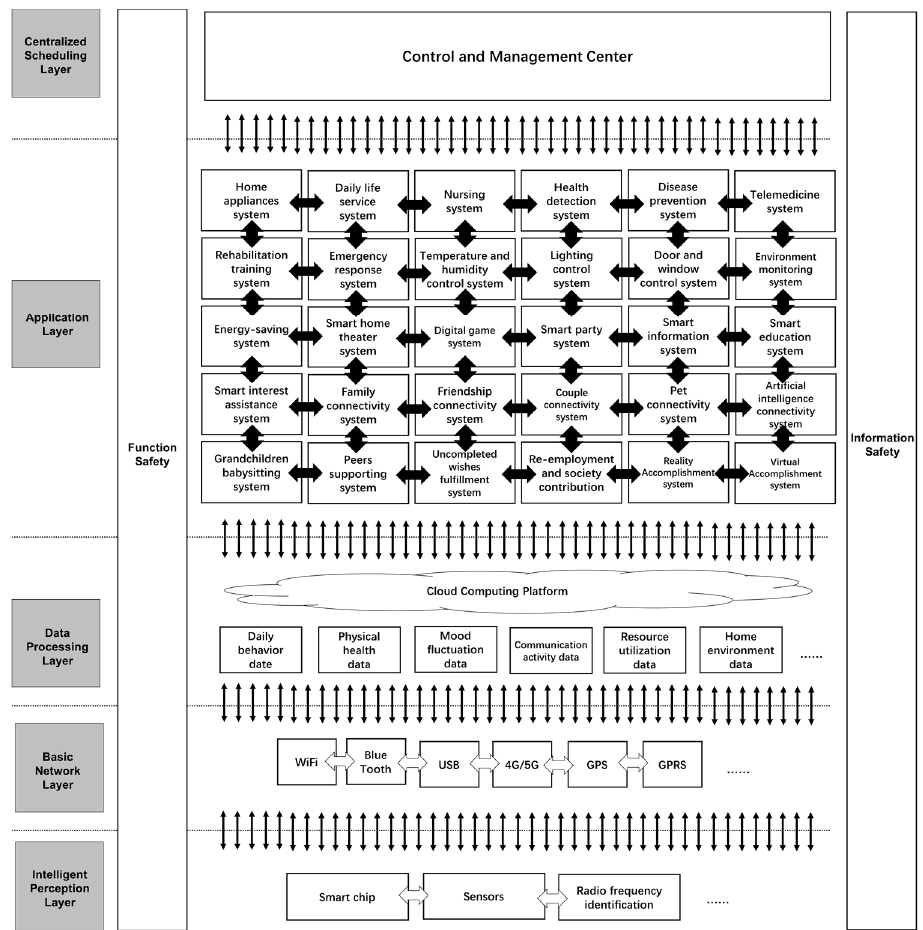
Figure 6. The construction of a smart home for new elders.